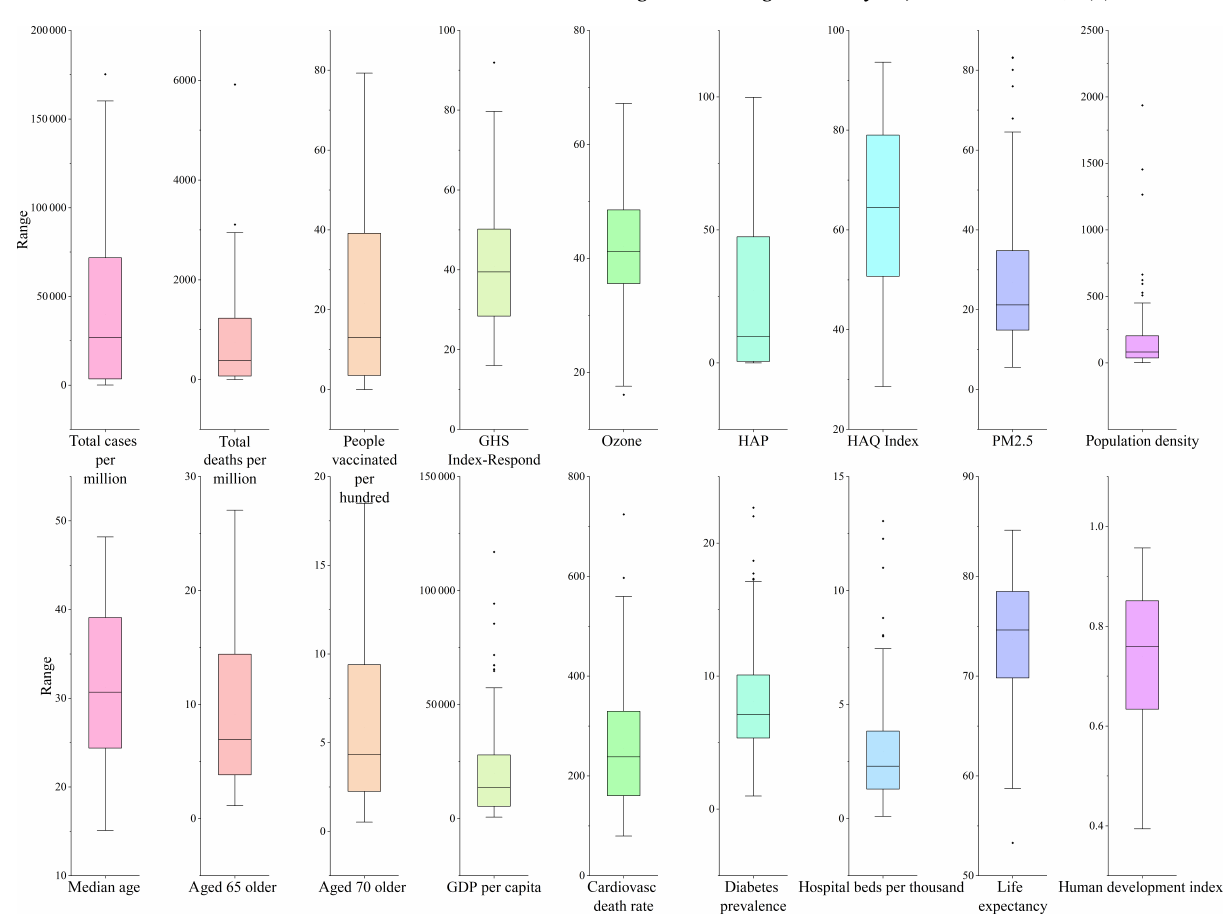
Fig. 4 Box plot dispersion status of some significant data related to COVID-19, including total cases and deaths per million, people vaccinated per hundred, Global health security index respond (GHS Index-Respond), ozone, Household air pollution (HAP), Healthcare access and quality (HAQ Index), PM2.5, population density, median age, aged 65 and 70 older, GDP per capita, cardiovasc death rate, diabetes prevalence, hospital beds per thousand, life expectancy, and human development